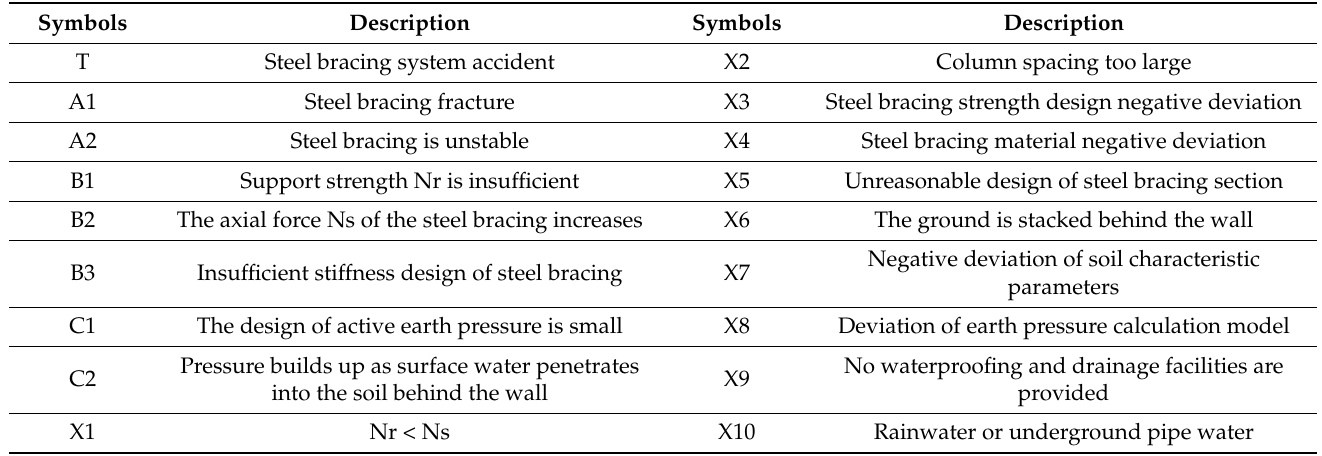
Table A1. A detailed description of the accident